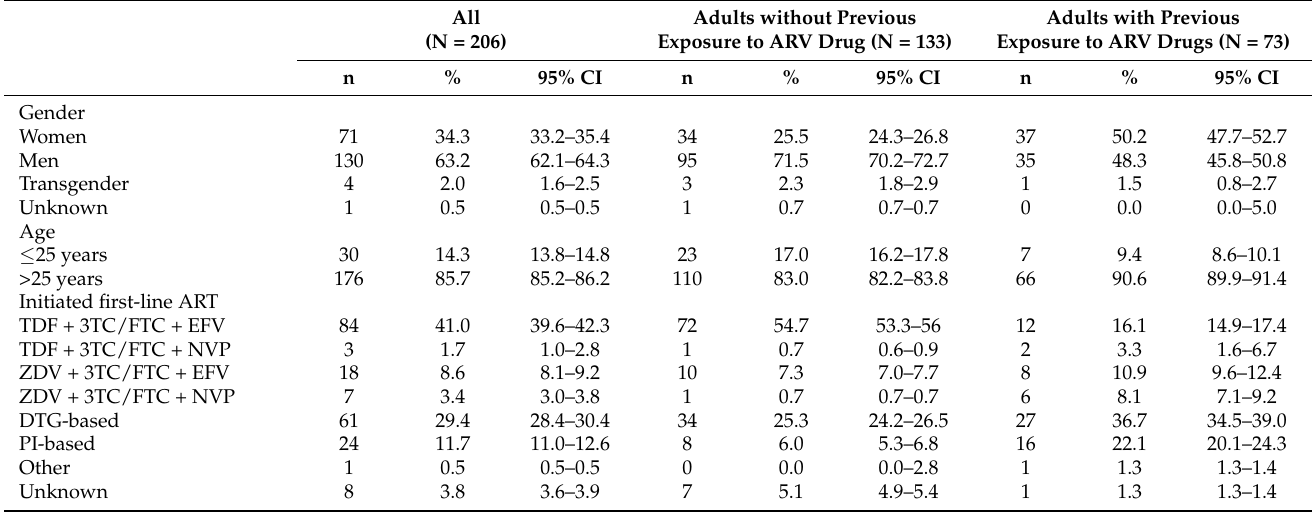
Table 1. Demographic and clinical characteristics of adults living with HIV initiating and reinitiating antiretroviral therapy with and without previous exposure to ARV drugs in Uruguay, 2018–2019.